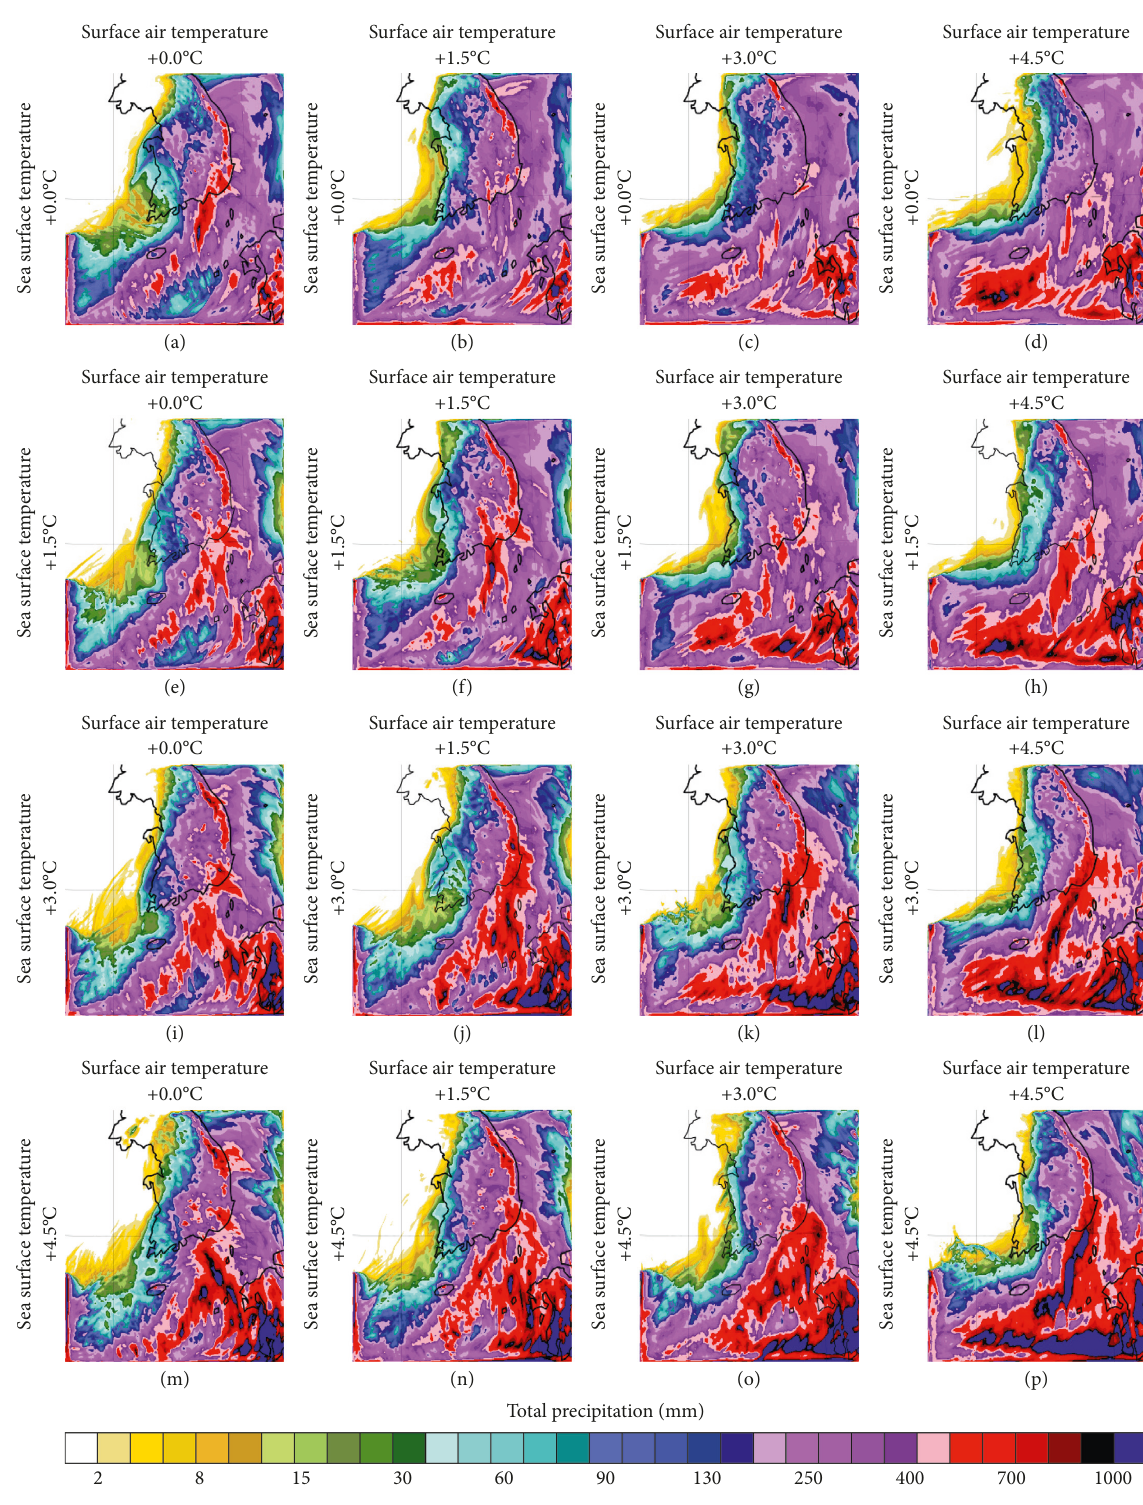
Figure 7: Total rainfall depth and its spatial distribution for various SAT/SST